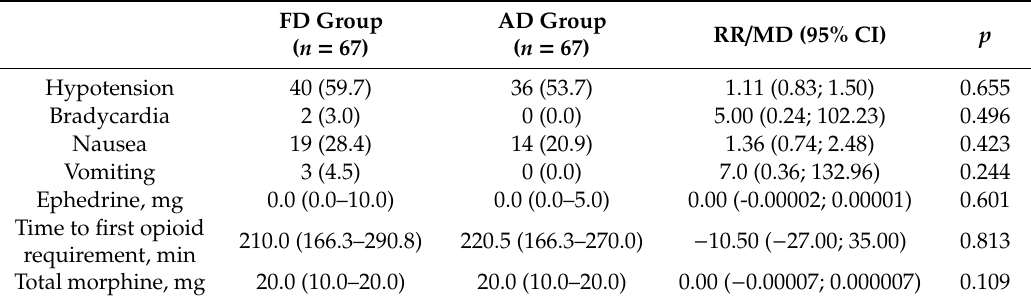
Table 4. Secondary outcomes. Data presented as n (%) or median (interquartile